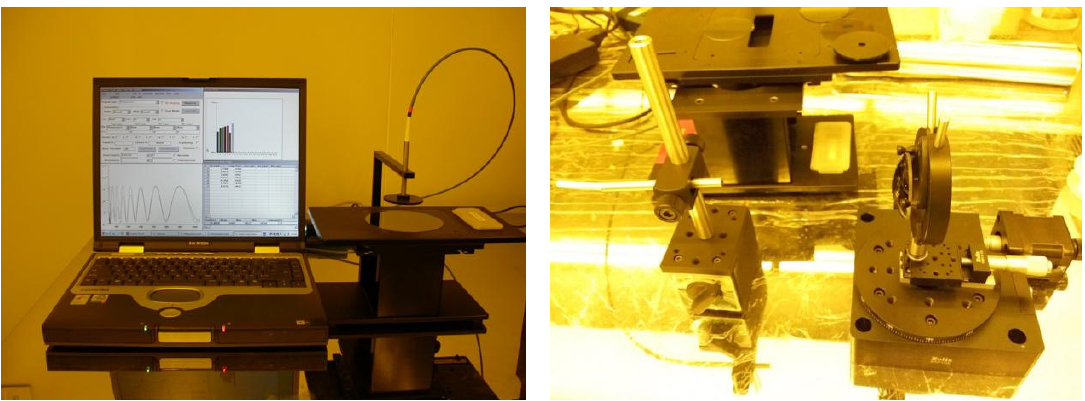
Figure 10. Self ‐ designed measurement system for film thickness distribution on spherical surface. Figure 10. Self-designed measurement system for film thickness distribution on spherical